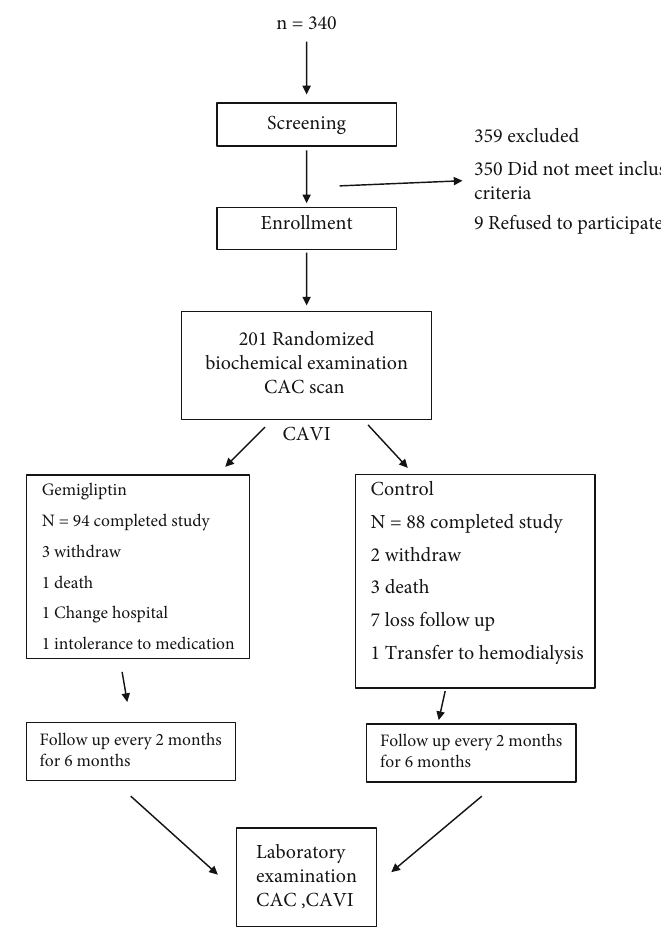
Figure 1: Enrollment, follow-up, and vital